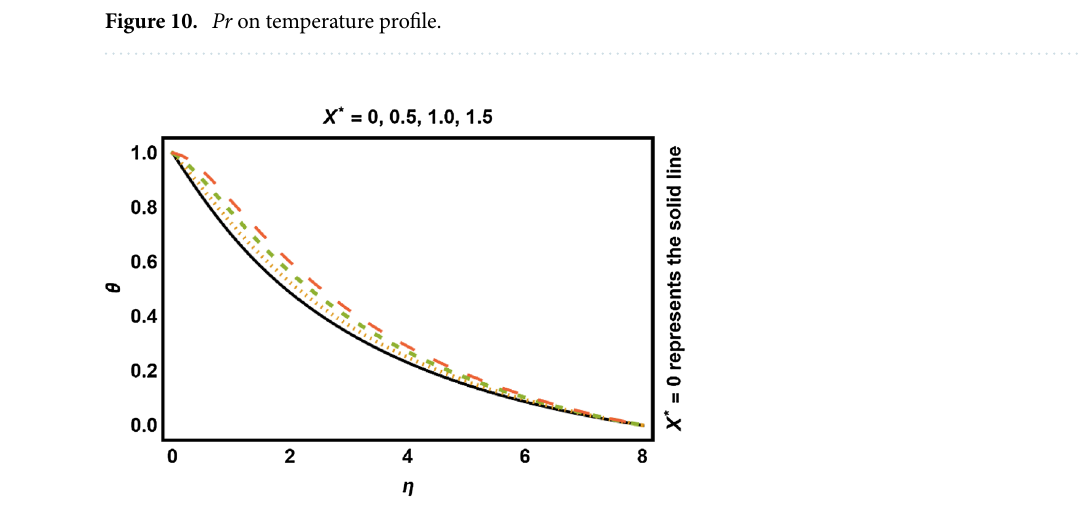
Figure 11. X ∗ > 0 on temperature field.